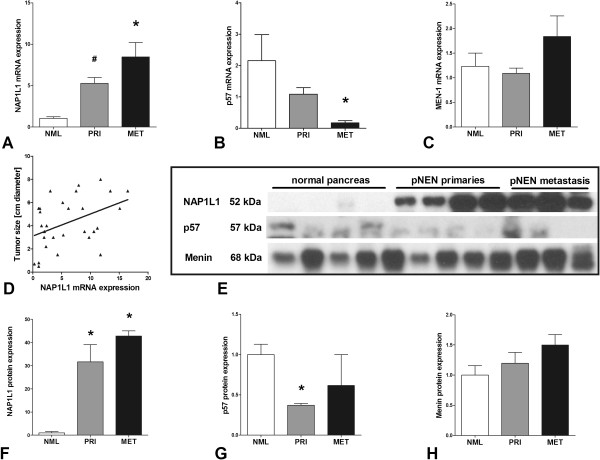
NAP1L1, p57Kip2, and menin expression in pancreatic neuroendocrine neoplasms compared to normal pancreatic tissue. NAP1L1 was increased at mRNA level (A) (Kruskal-Wallis p < 0.001) in pNEN primaries (#p < 0.01) and metastases (*p < 0.01) and expression correlated with tumor size (D) (r = 0.42, p < 0.05). In contrast, p57Kip2 mRNA was downregulated in pNEN metastases (B) (*p < 0.01). Menin was not differently expressed in pNEN in comparison to normal tissue in this sample set (C and H). Western blot analysis (E) confirmed elevated NAP1L1 protein levels (F) (*p < 0.05) and downregulated expression of p57Kip2 in pNENs (G) (*p < 0.05). Mean ± SEM.